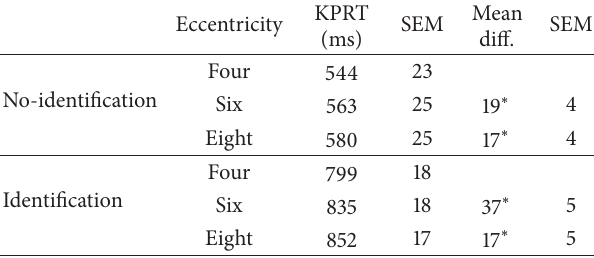
Table 1: Mean key-press RT (KPRT) in milliseconds (ms) for the two-way interaction of target-feature-identification × eccentricity with standard errors (SEM). Columns to right show Bonferroni corrected mean differences for paired comparisons of 4 ∘ to 6 ∘ and 6 ∘ to 8 ∘ .